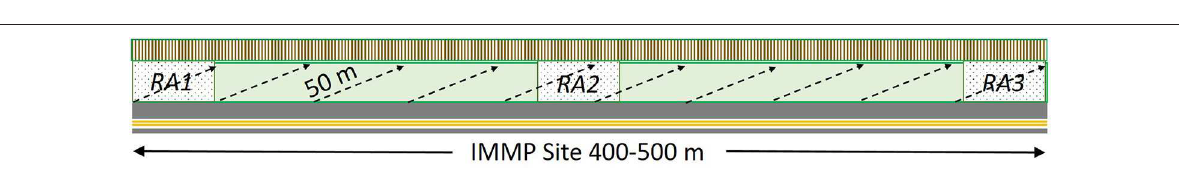
FIGURE 2 | Overlay of Rapid Assessment (RA) and Integrated Monarch Monitoring Program (IMMP) for the comparison of protocols. The IMMP uses ten 50m long transects arrayed diagonally 400–500m along the roadway. In our comparison trials, 2–4 Rapid Assessments were completed for each IMMP site, typically established at the ends and middle of each IMMP